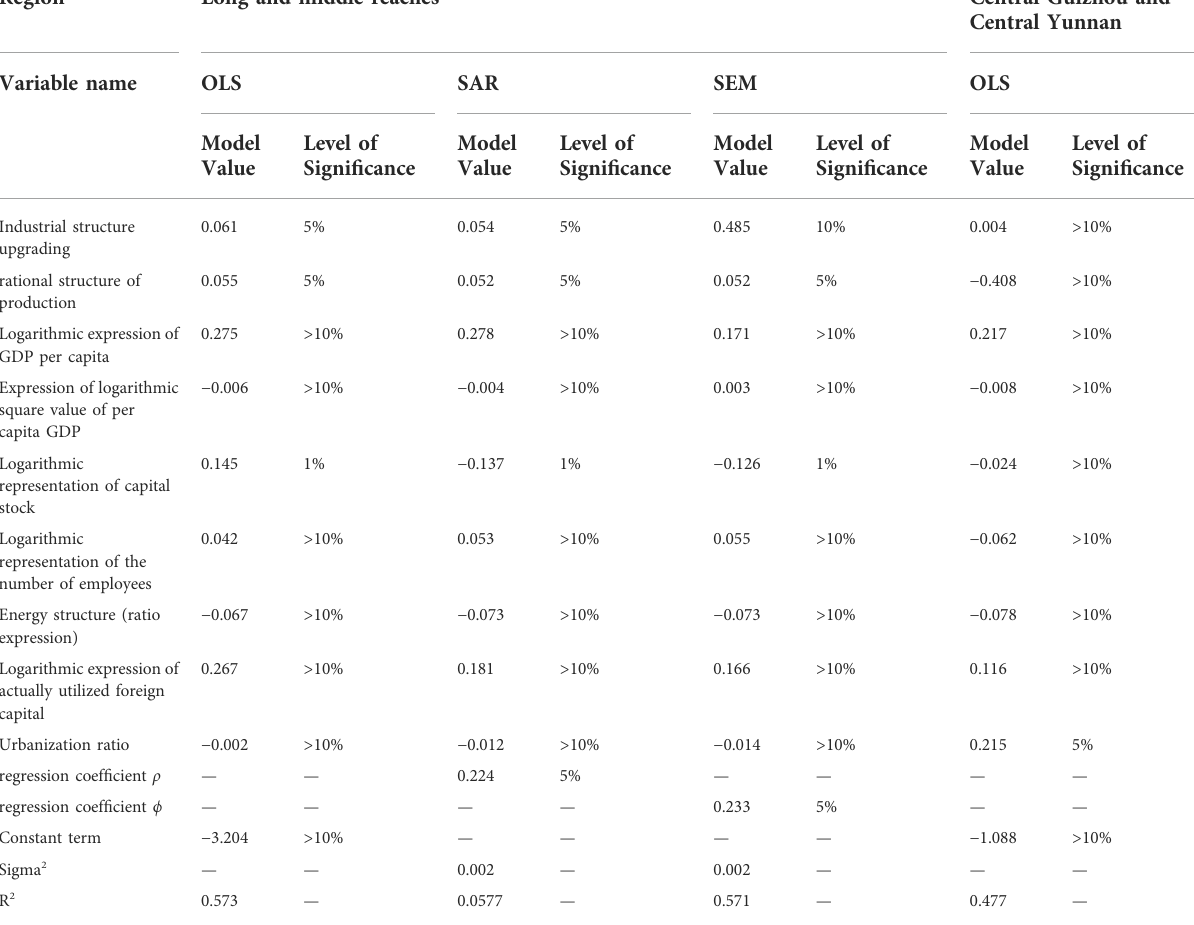
TABLE 6 Empirical results of the middle yangtze river region and the central guizhou yunnan region.